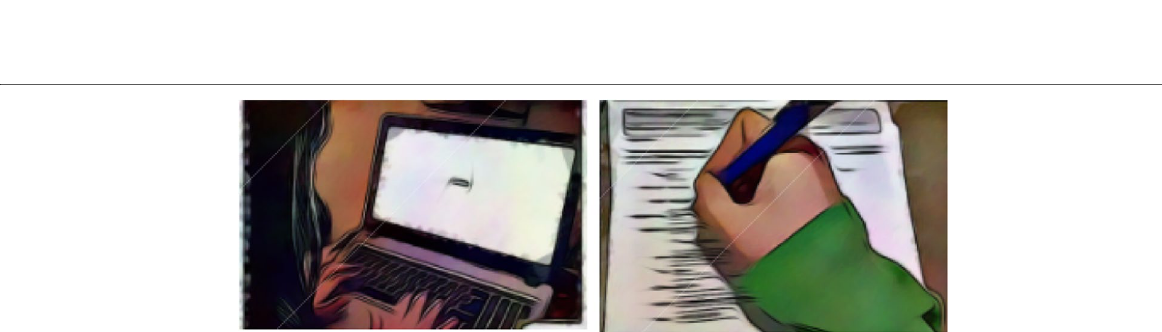
Fig. 1 RCT task. The task was counterbalanced in the order of presentation of reading material according to media type: digital or print (left versus right). Finally, written comprehension questions were asked in written form